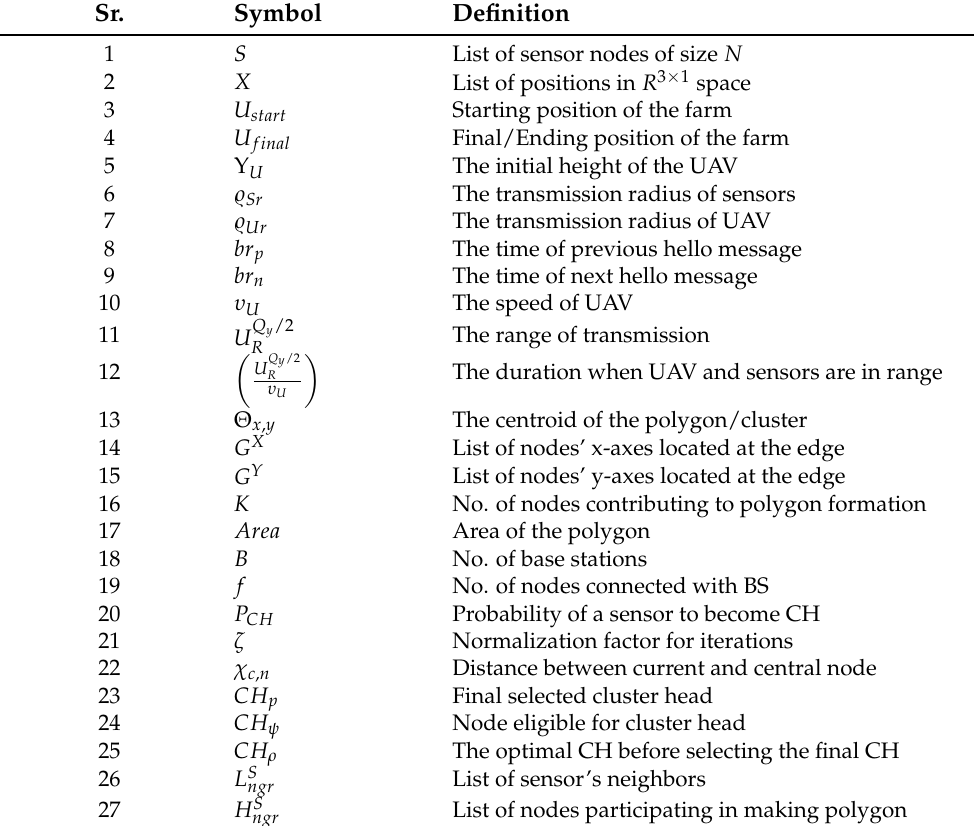
Table 1. Summary of